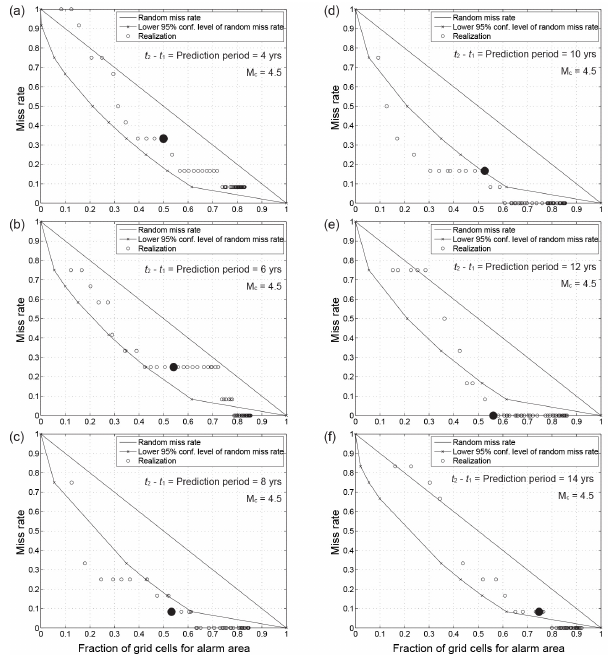
Fig. 11. As in Fig. 9, but for a cutoff magnitude of